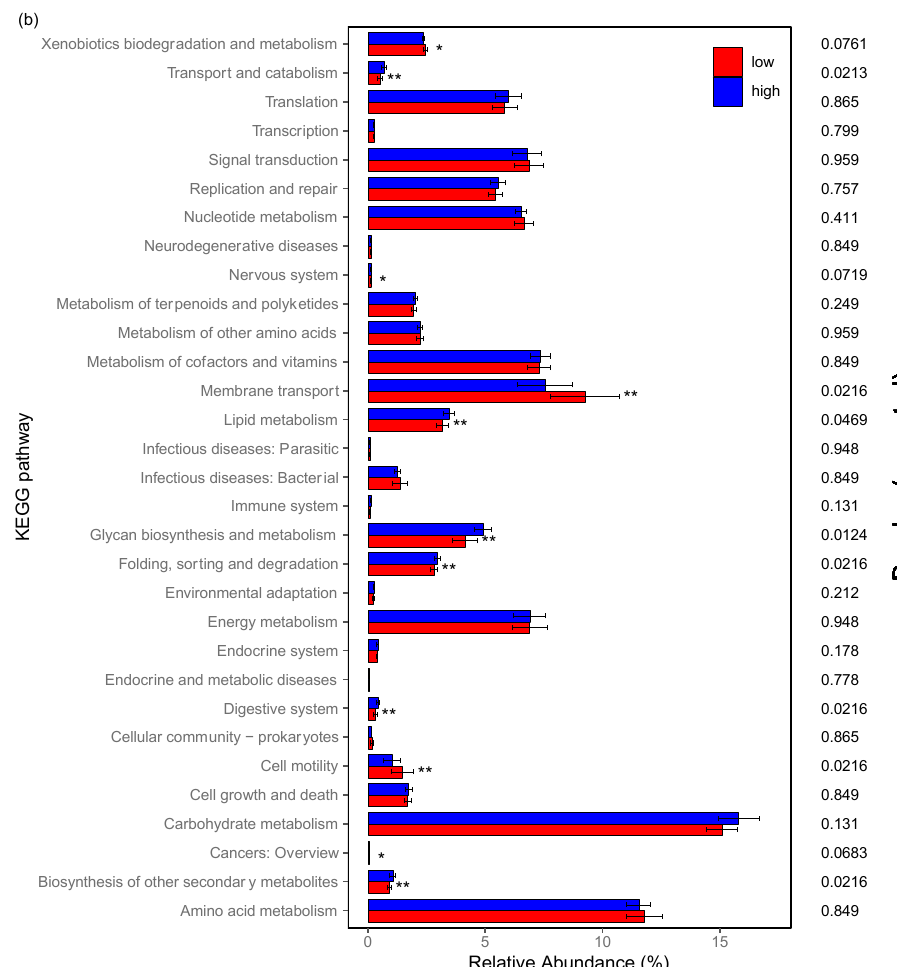
Figure 4. Functional pathway analysis of the gut microbiome based on PNS level (low vs. high). Based on the KEGG pathway, significant metabolism pathways are presented adjusting by the Benjamini–Hochberg method. ( a ) indicates all the 41 pathways based on KEGG annotations and ( b ) presents 31 pathways based on KEGG annotations using mean abundance larger than 5%. PNS, psychoneurological symptoms; KEGG, Kyoto Encyclopedia of Genes and Genomes. * p < 0.10; ** p < 0.05 .